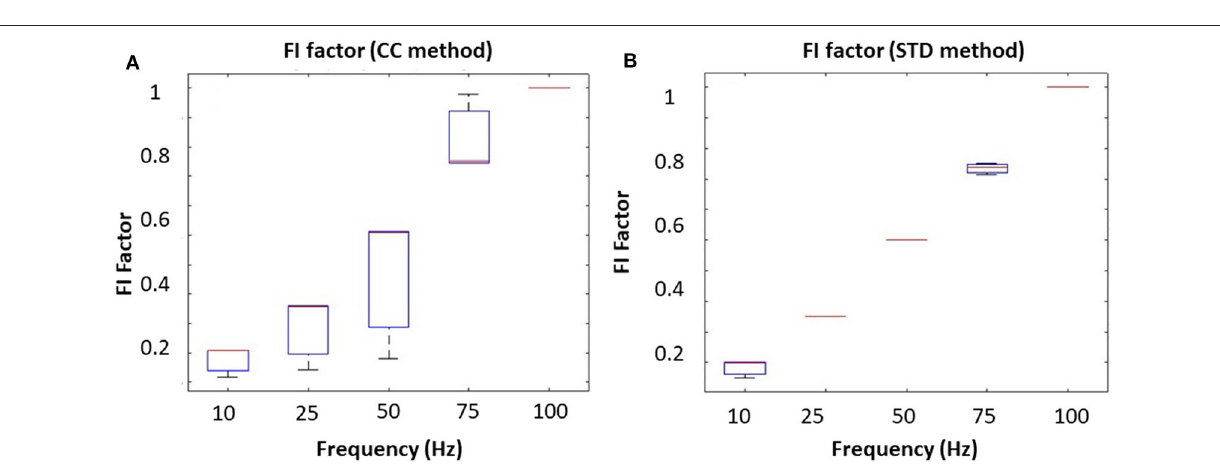
Frontiers in Physics |